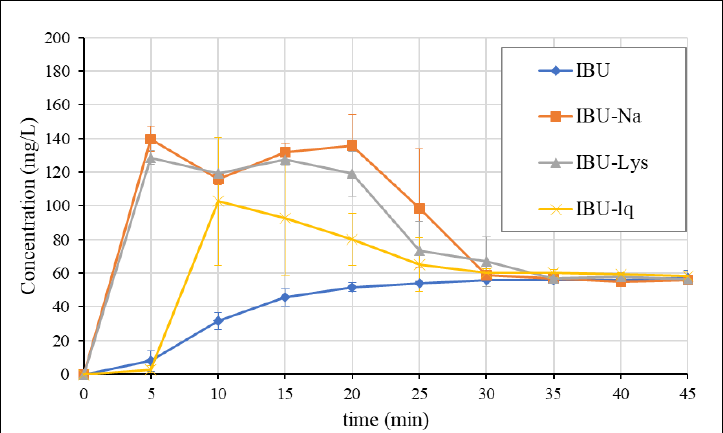
Figure 5. Gastric concentration profiles of ibuprofen formulations (1 × 200 mg) in blank biorelevant media.